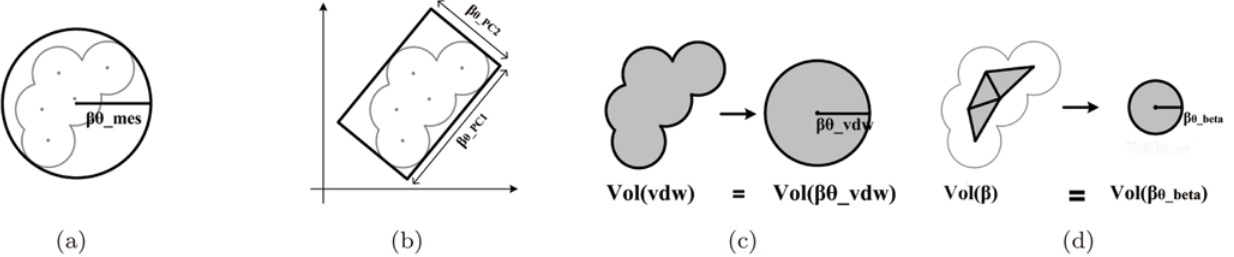
Fig 3. L-descriptor types in the plane. (a) The minimum enclosing sphere and β θ _mes, (b) the bounding box by PCA, β θ _PC1, and β θ _PC2, (c) the van der Waals model of the ligand and β θ _vdW, and (d) the beta-shape of the ligand and β θ _beta.